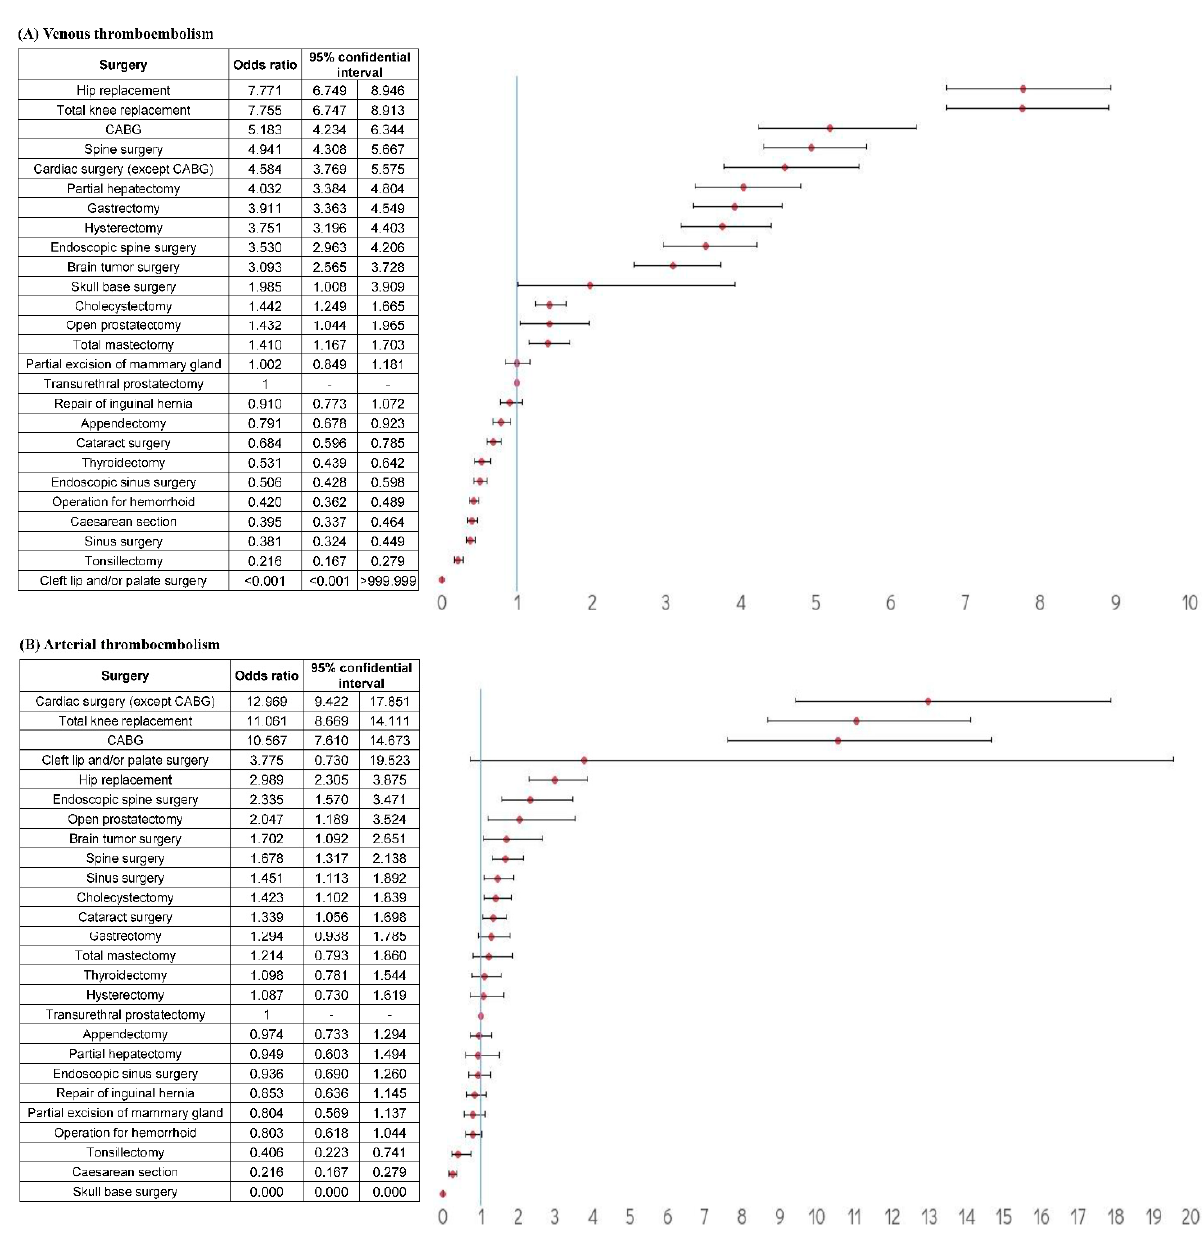
Figure 2. Odds ratios of total claimed thromboembolism events for each type of surgery after correcting for thromboembolism risk factors. Abbreviation: CABG, coronary artery bypass graft. ( A ) The